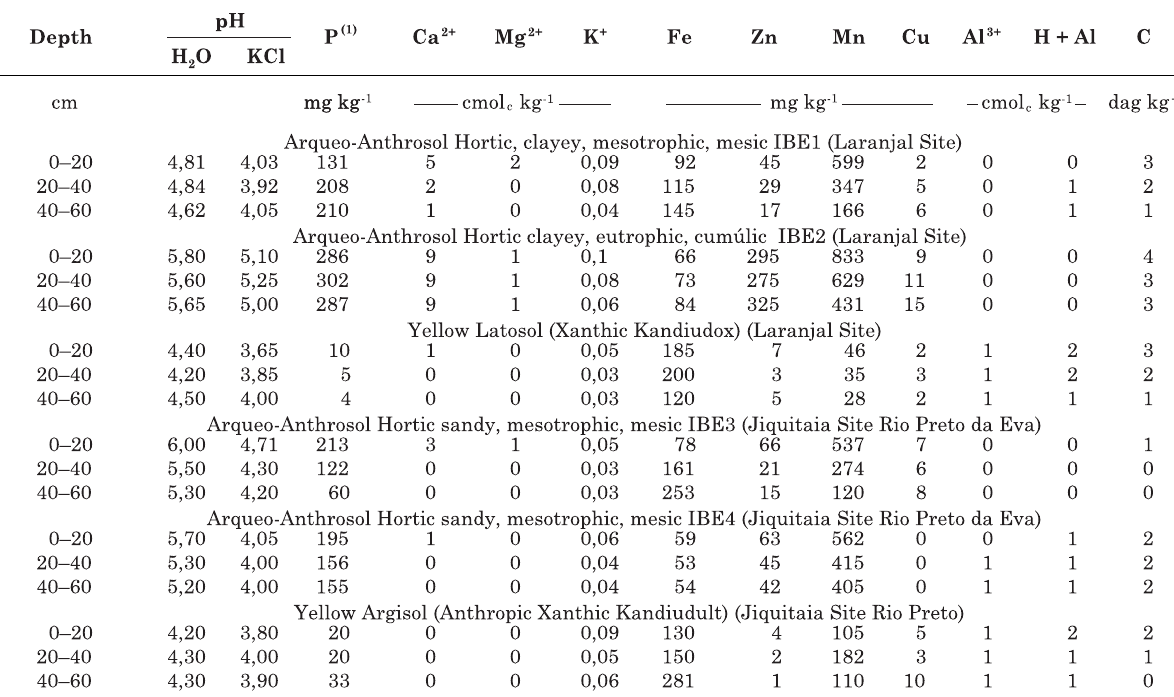
Table 2. Chemical characteristics of IBE